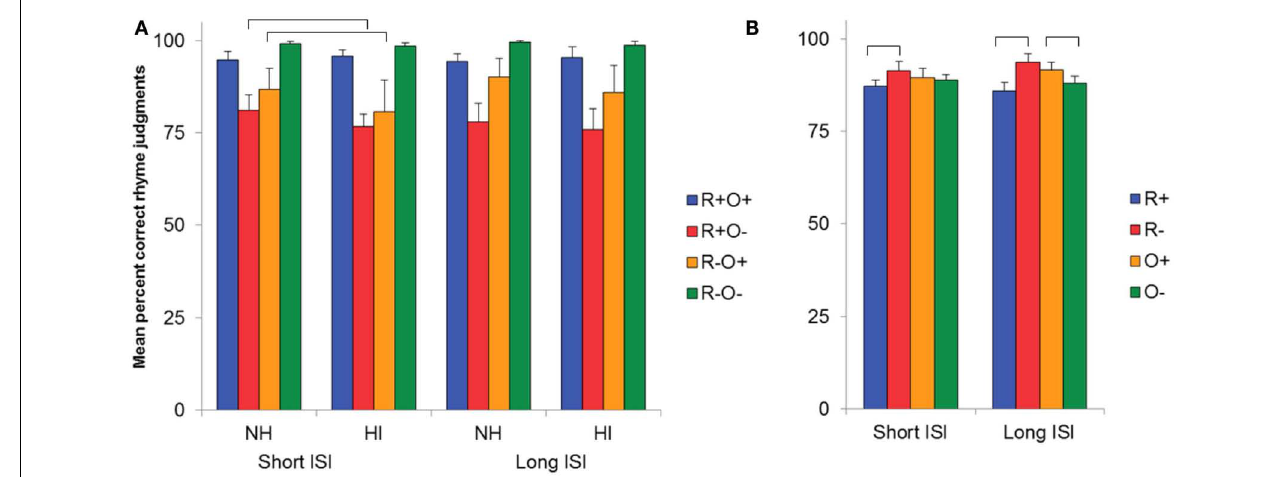
non-rhyming (R − ), orthographically similar (O + ) and orthographically dissimilar (O − ) conditions, all participants, in short and long ISI. Error bars represent 95%